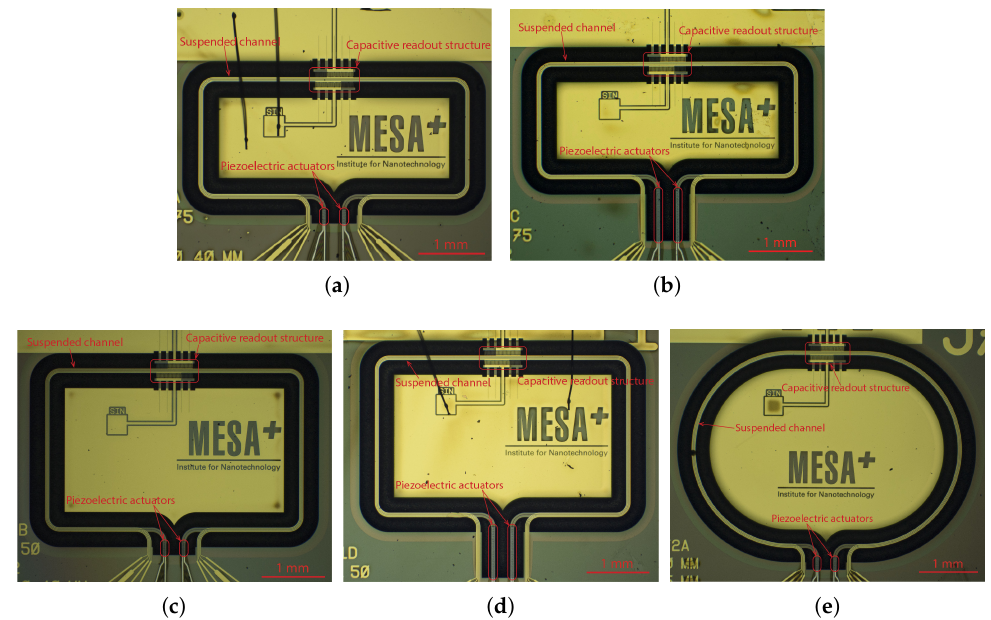
Figure 1. Optical microscope photographs ( a – e ) of the 5 micro-Coriolis mass flow sensor devices that were used for Q factor measurements. The position of the capacitive readout structures and piezoelectric actuators are indicated. Using these 5 different devices allowed the measurement of quality factor at 20 different resonance frequencies in the range from 1.8 kHz to 16 kHz.